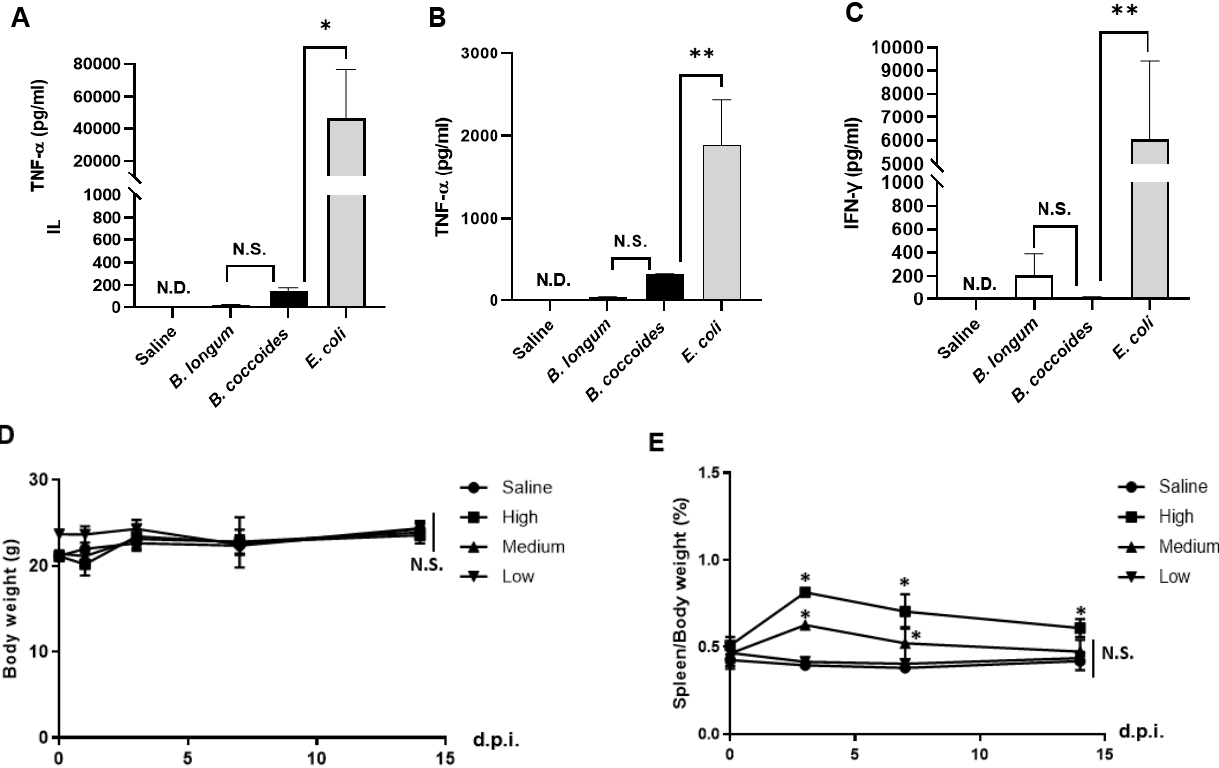
Figure 4. Adverse e ff ects after intravenous administration of B. coccoides JCM1395 T . ( A ) Tumor necrosis factor- α and ( B ) interleukin-6 concentration in serum at 1.5 h, and ( C ) interferon- γ concentration in serum at 6.0 h after intravenous injection of saline, B. coccoides JCM1395 T (6.7 × 10 7 CFU), B. longum JCM1217 T (3.0 × 10 7 CFU), and E. coli (3.4 × 10 7 CFU). ( D ) Body weight and ( E ) spleen weight changes after intravenous injection of low-dose (5.4 × 10 5 CFU), medium-dose (2.7 × 10 7 CFU), and high-dose (2.7 × 10 8 CFU) B. coccoides JCM1395 T . * p < 0.05; ** p < 0.01. Each value represents the mean ± SD ( n = 3). N.D., not detected. N.S., not signi fi cant.